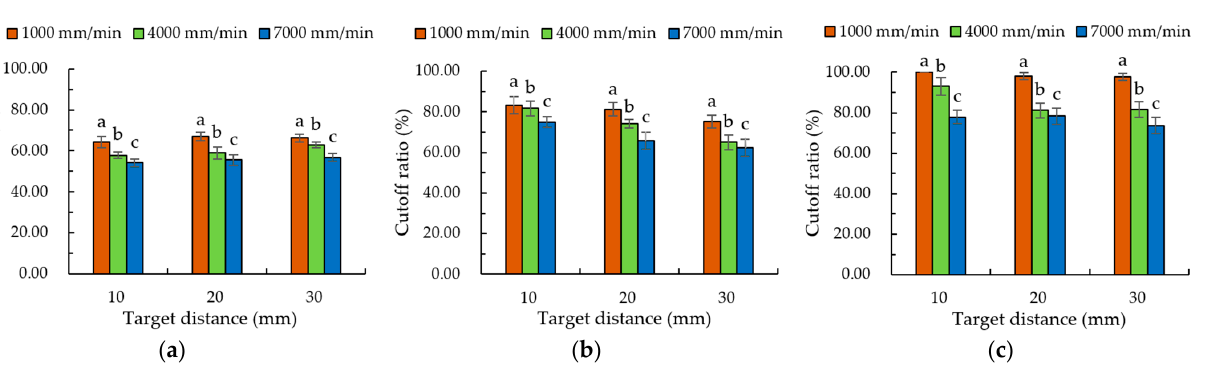
Figure 5. Experimental results of di ff erent cu tt ing parameters. ( a ) 40 MPa; ( b ) 80 MPa; ( c ) 120 MPa.